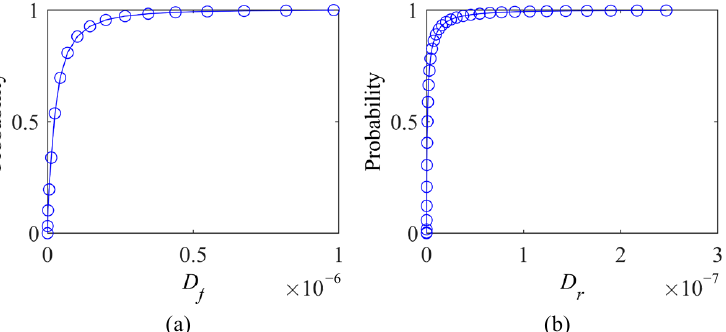
Figure 12. Results of the cumulative probability distributions for the damage of ( a ) fatigue failure (A4) and ( b ) rutting (B1) under a single random load.